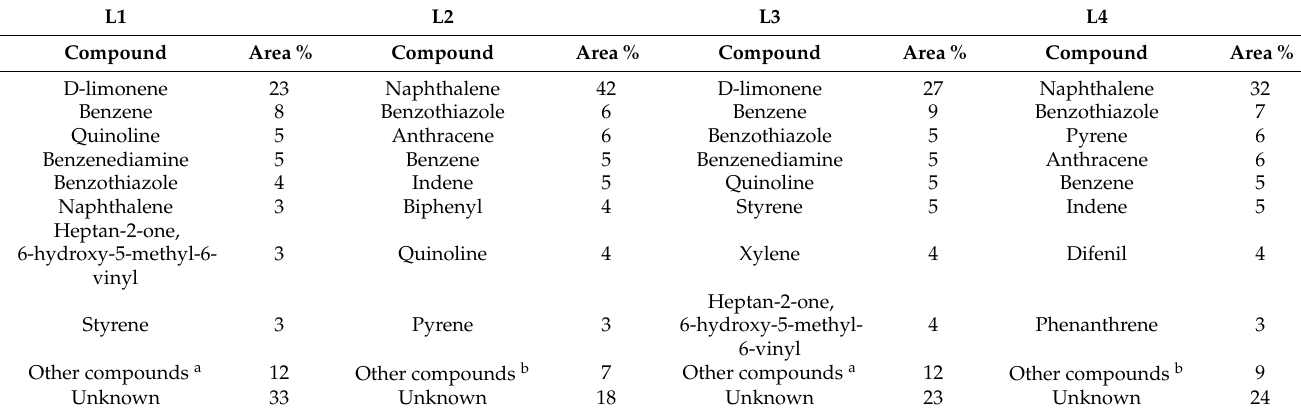
Table 4. Main compounds found within the liquid fraction from each process expressed as area